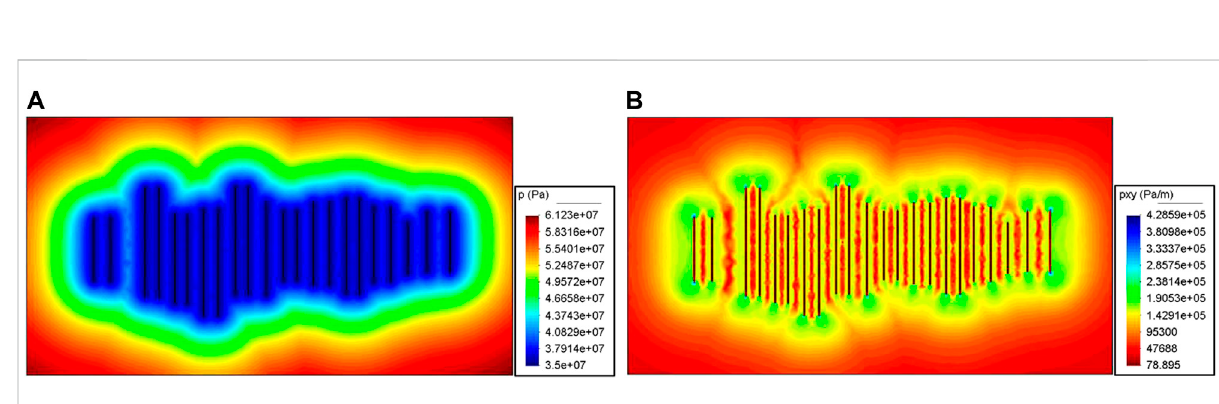
FIGURE 2 Distributionofformationpressureandpressuregradient. (A) .Distributionofformationpressure, (B) .Distributionofformationpressuregradient.